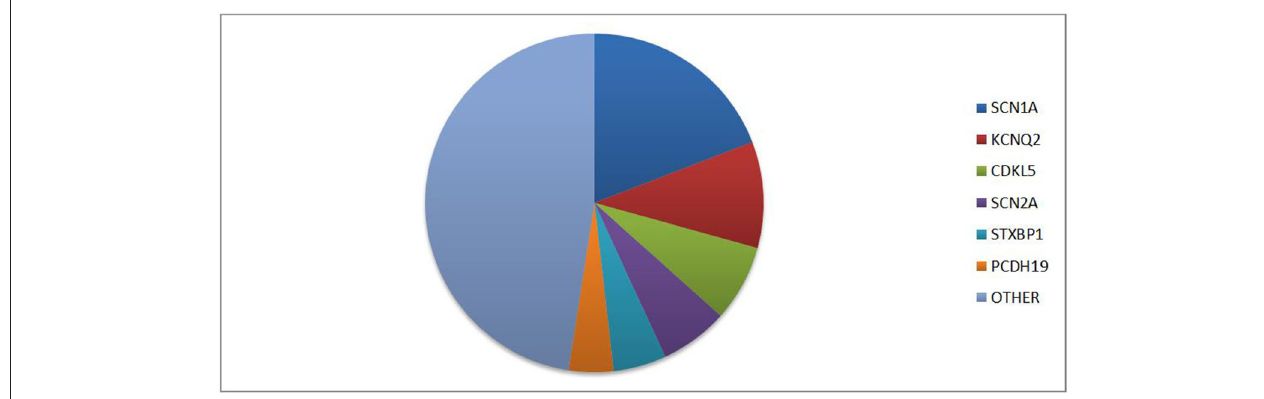
FIGURE 1 | Prevalence of different gene mutations in genetic epilepsies according to literature data [data from